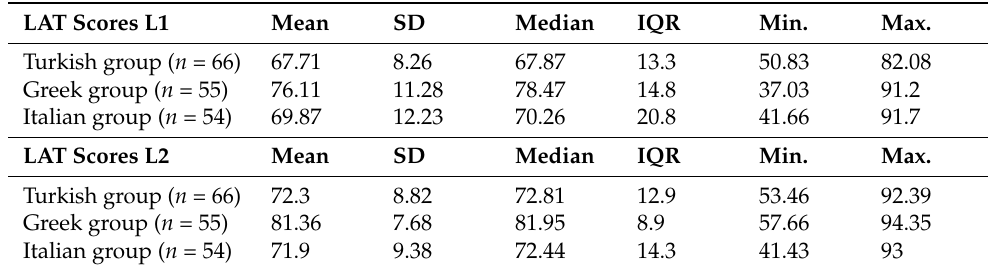
Table 4. LAT scores in L1 and L2 across language groups.